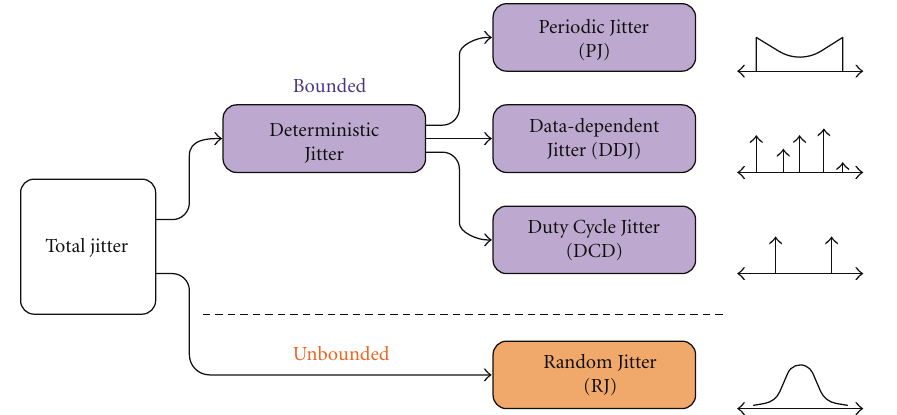
Figure 4: Jitter classification scheme [22].